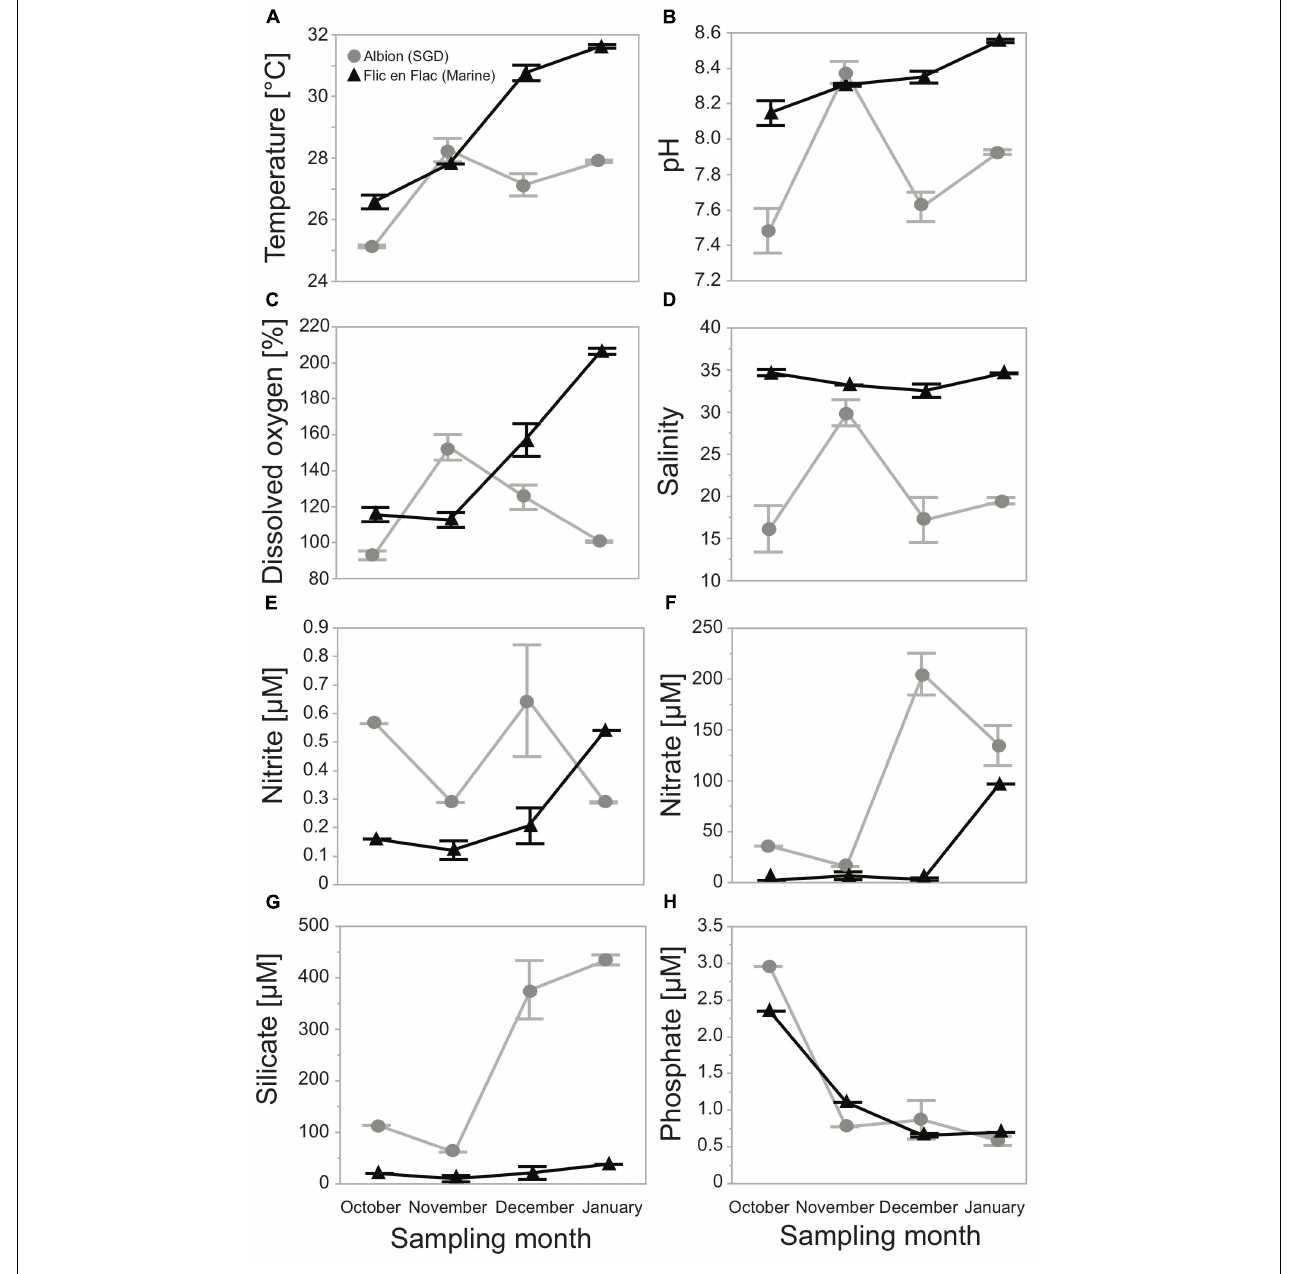
FIGURE 2 | Monthly time series of physico-chemical parameters recorded inside a tide pool influenced by fresh SGD at Albion (SGD, gray dots) and inside a strictly marine tide pool at Flic-en-Flac (Marine, black triangles): (A) Water temperature, (B) water pH, (C) water dissolved oxygen content, (D) salinity, (E) nitrite, (F) nitrate, (G) silicate, and (H) phosphate